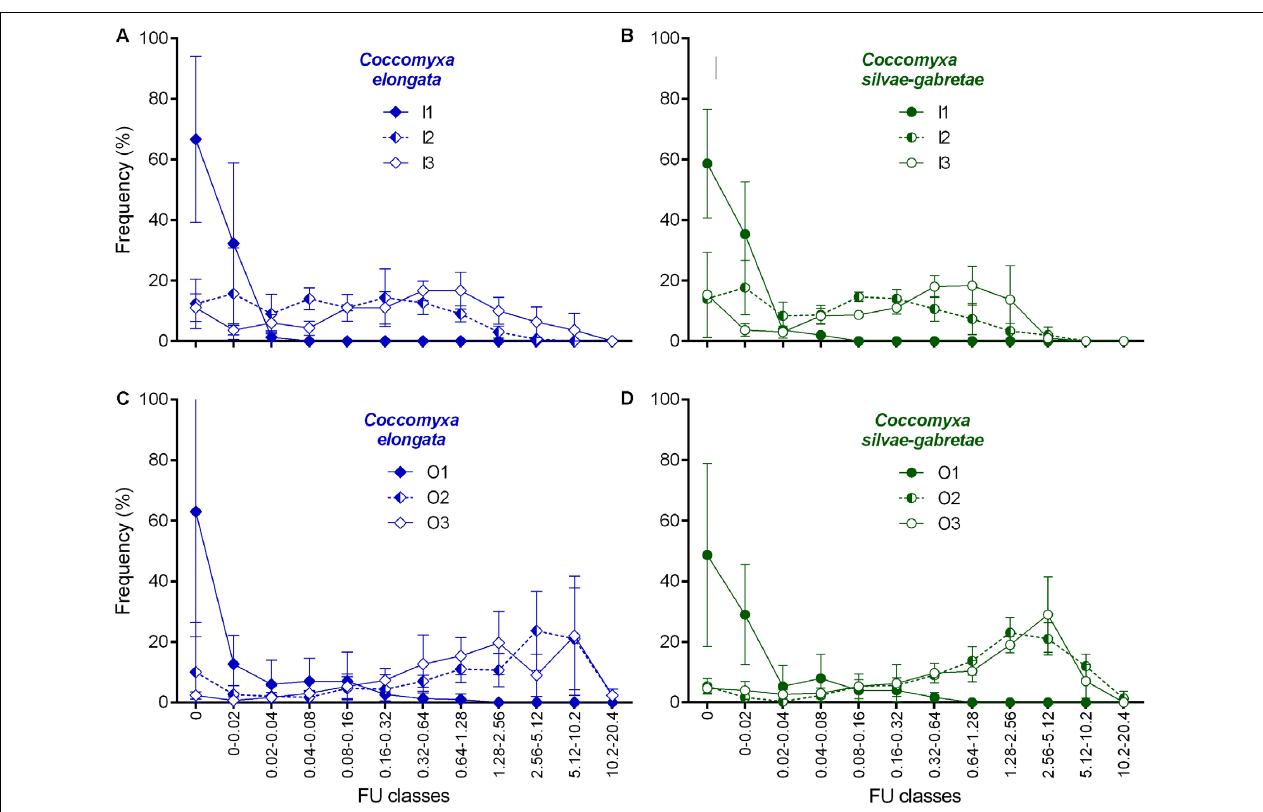
FIGURE 6 | Frequency distribution of cell-specific phosphatase activity (in relative FU cell − 1 h − 1 ) in the Coccomyxa cultures in P-replete (1) and P-depleted (2 and 3) media with either inorganic (I; top: A,B ) or organic (O; bottom : C,D ) P source. Except for zero classes (no activity), all FU classes are expressed in a geometric progression to cover broad range of ELFA fluorescence. All symbols are means of triplicates, bars represent SDs; note same scales; 100% is the sum of means in a variant. The total cell number (in a variant) measured for C. elongata : 300 (I1), 360 (I2), 420 (I3), 357 (O1), 360 (O2), 360 (O3), and C. silvae-gabretae : 300 (I1), 360